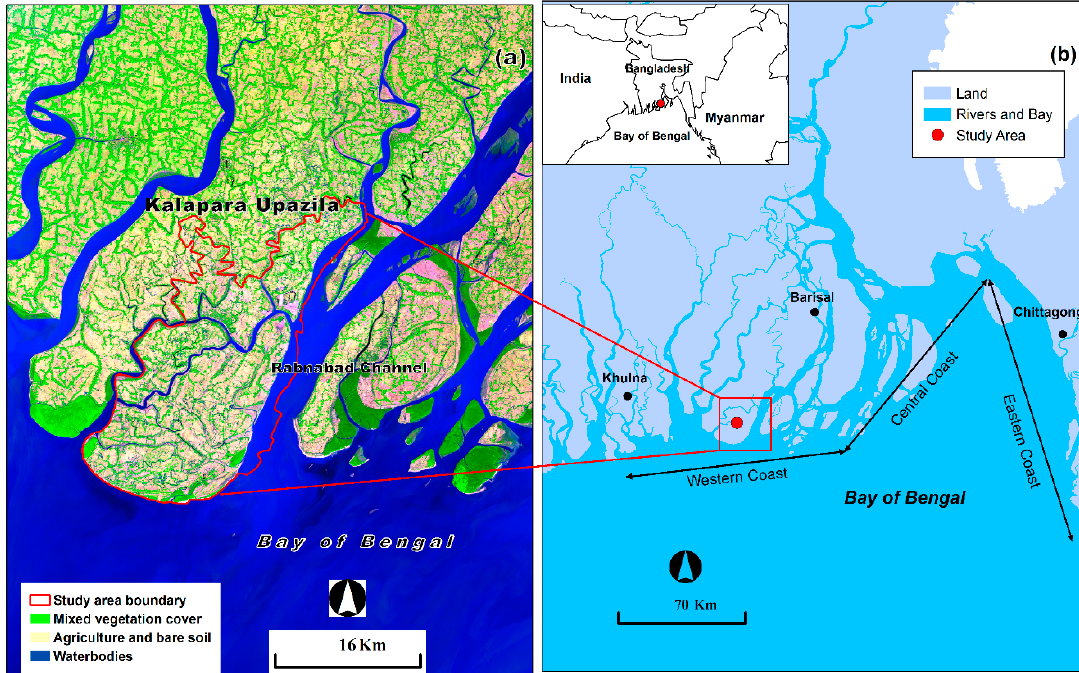
Figure 1. ( a ) Location of study area mapped on Landsat 8 OLI (Operational Land Imager) image of 20 January 2018, ( b ) study area in the context of the coastal region of Bangladesh.